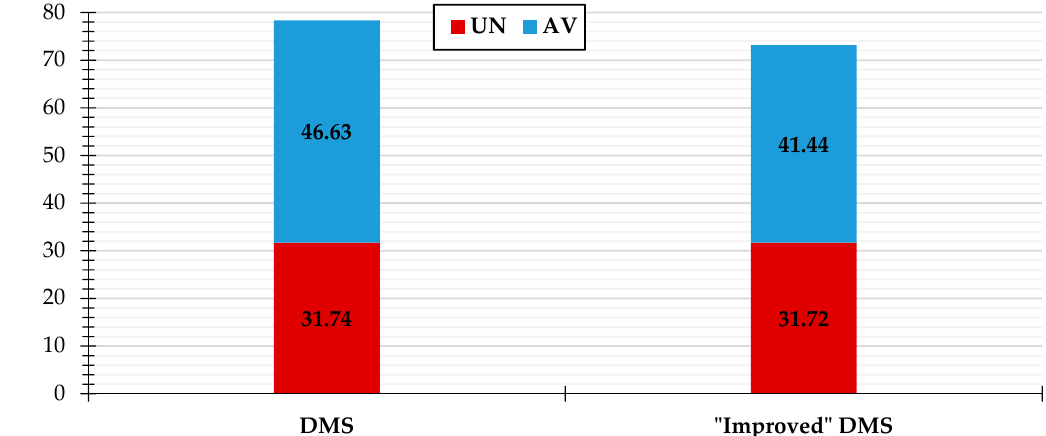
Figure 6. Comparison of the exergy destruction rates associated with the reference (DMS) and improved (“Improved” DMS) systems at the outdoor temperature of 40 °C.